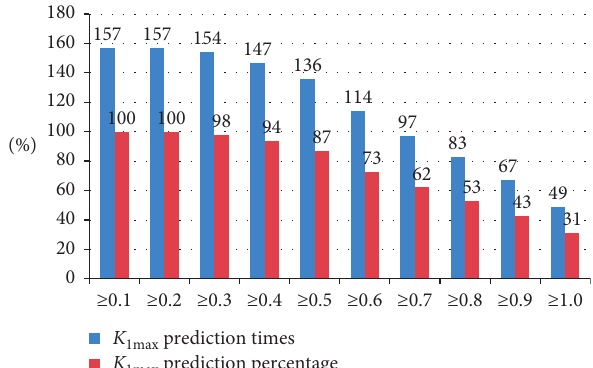
1max of max ( Φ 42mm)